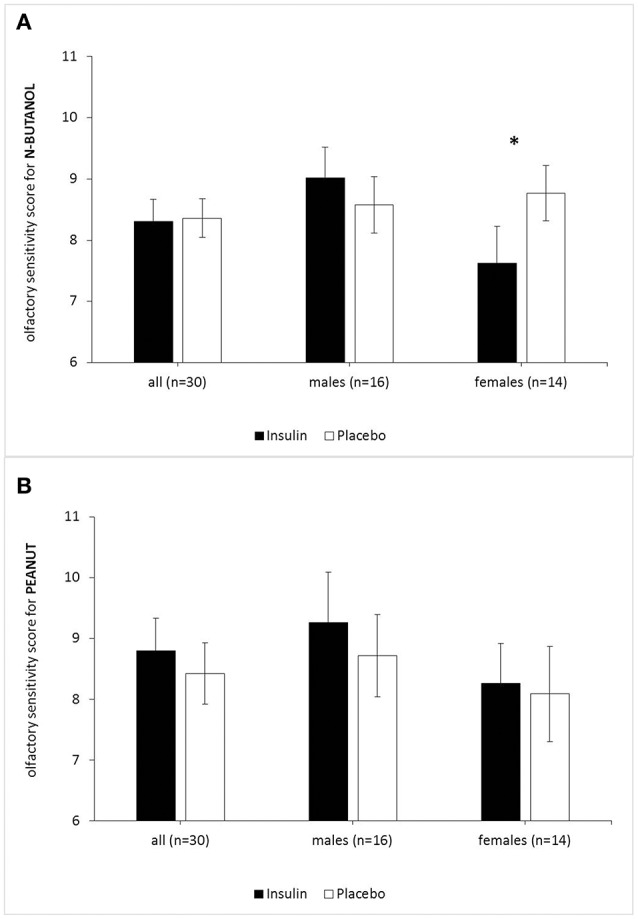
Acute effects of intranasal insulin (40 IU, black bars) and placebo (0.4 ml, white bars) on olfactory sensitivity (highest olfactory sensitivity score = 16) for the odorants peanut (A) and n-butanol (B). n = 30 (males n = 16, females n = 14). While females showed reduced olfactory sensitivity for n-butanol (p = 0.045) after intranasal insulin, males did not. Olfactory sensitivity for peanut was not influenced by intranasal insulin in both genders. Data are provided as means and SEMs; *p < 0.05.